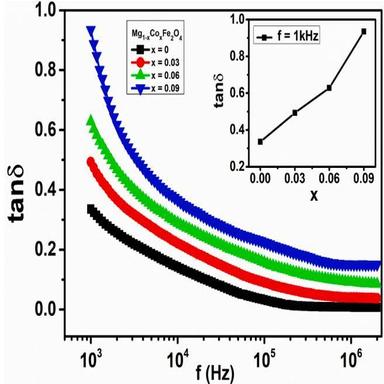
Variation of Tangent loss versus frequency (Hz) of Mg1-xCoxFe2O4 with (x = 0, 0.03, 0.06, and 0.09) nanoparticles, while insets show variations of Co concentrations versus Tangent loss.